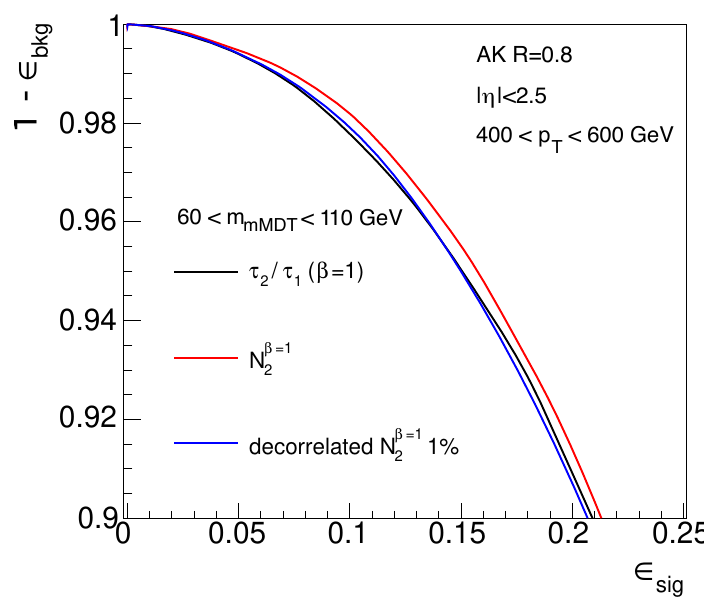
Figure 2 . Quark/gluon jet background rejection power 1 (cid:0) 2 bkg as a function of the W jet selection e(cid:14)ciency 2 sig for various substructure observables under study combined with a selection of 60 < m mMDT < 110